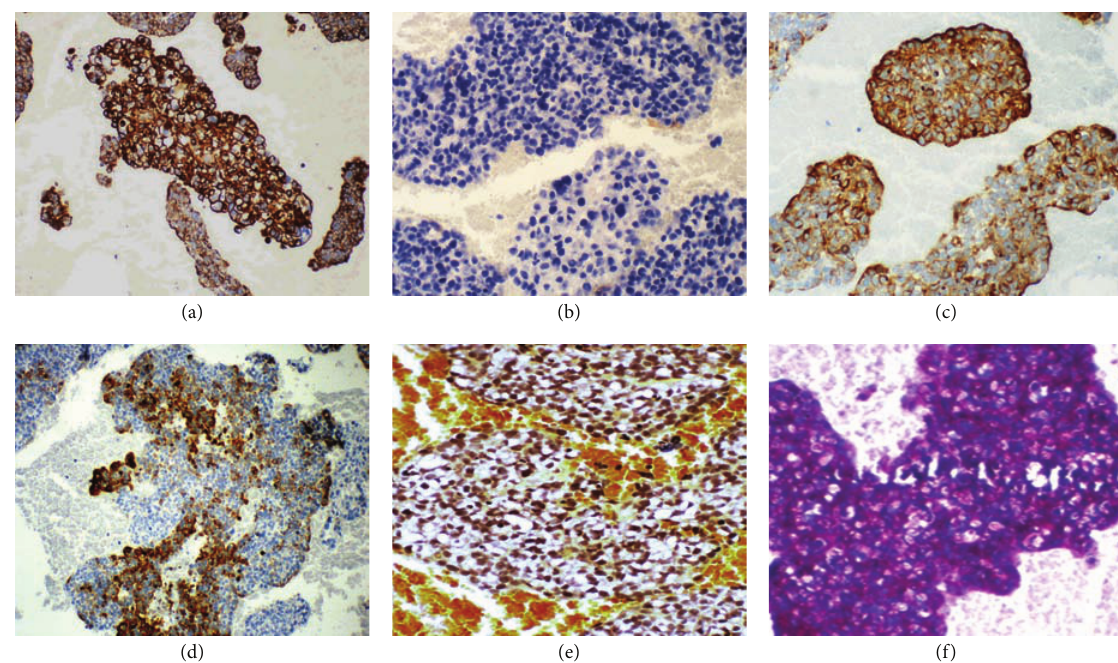
Figure 3: Ancillary studies of CK7, CK20, EMA, CK5/6, Mucin, and